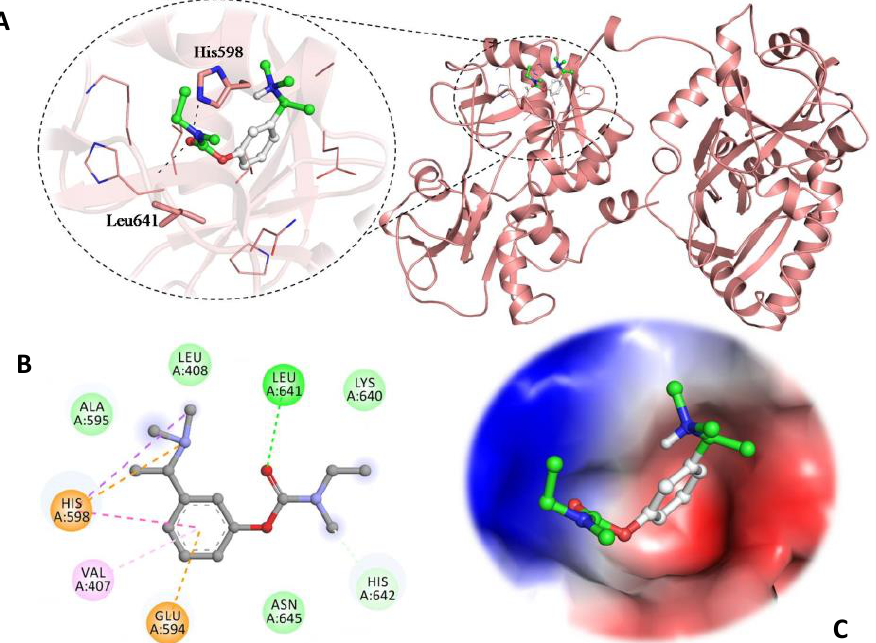
Figure 7. Cartoon representation of hTf in a complex with RT: Polar interactions sharing residues are shown in the stick element colour, and other interacting residues are shown in the line model. ( A ) Three-dimensional view of binding pocket residues of human serum transferrin interacting with RT. ( B ) Two-dimensional diagram of hTf residues interacting with RT. ( C ) Charged surface view of hTf binding pocket occupied by RT.